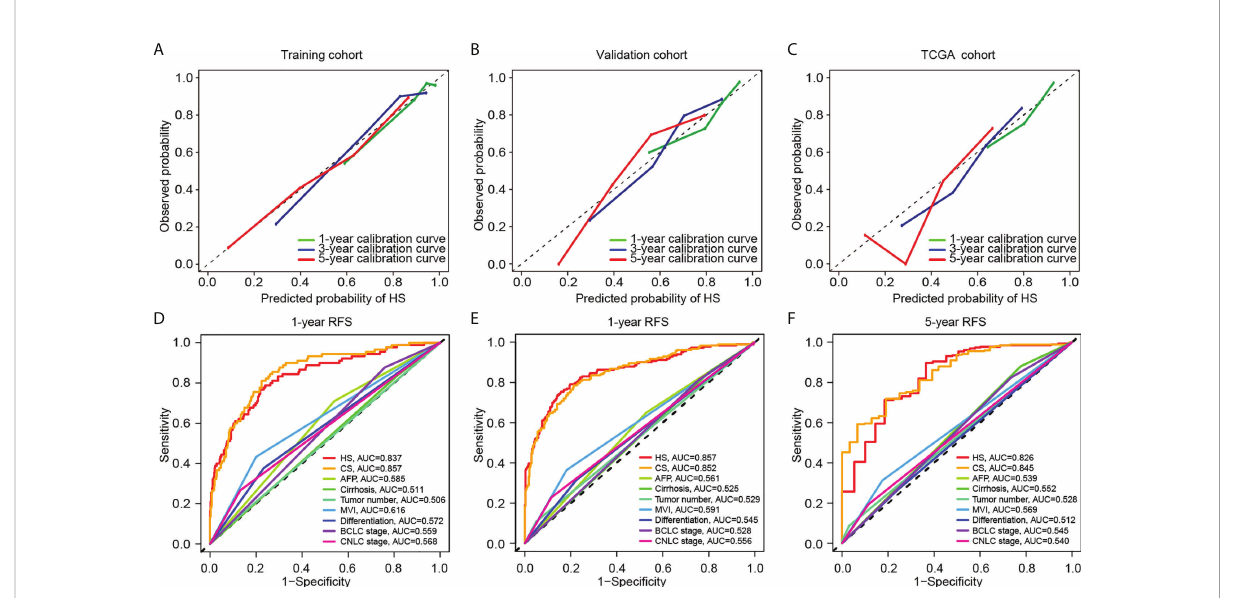
FIGURE 3 Comparison of predictive performance between two novel models. Upper: The calibration curves for TTR of HS in the training (A) , validation (B) , and TCGA cohort (C) . Down: The ROC curves for 1-year (D) , 3-year (E) and 5-year (F) RFS based on different clinicopathological features and stages. TCGA, The Cancer Genome Atlas; RFS, recurrence-free survival; HS, histological score; CS, combined score; AFP, alpha-fetoprotein; MVI, microvascular invasion; BCLC, Barcelona Clinic Liver Cancer; CNLC, China Liver Cancer; AUC, area under the